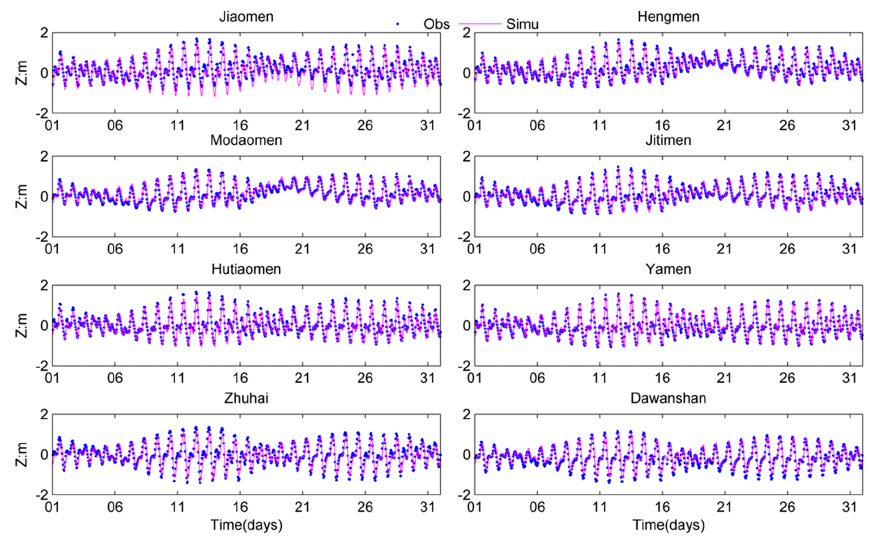
Figure 4. Comparisons of the simulated (purple lines) and observed (blue dots) water levels at eight water level stations during July 2006. Locations for the tidal stations are shown in Figure 1. Table 2. Statistics for the hydrodynamic and water quality model validation.